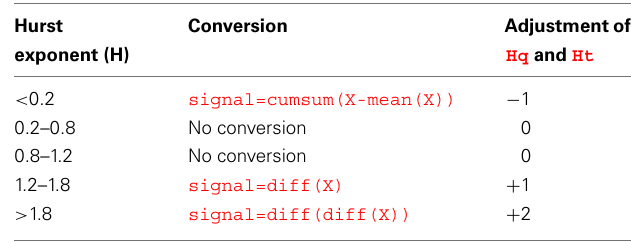
Table 1 | Conversions of the biomedical time series X and adjustment of Hq and Ht